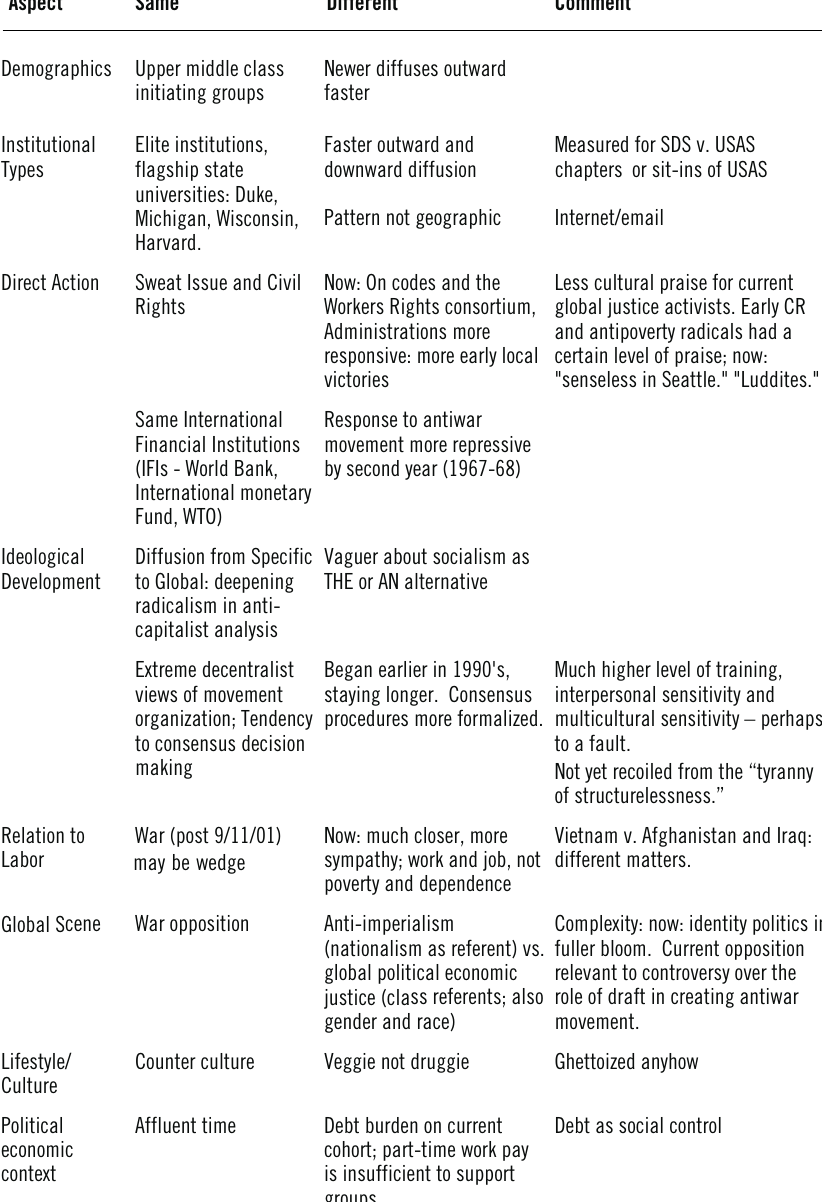
Table 2: Comparing the Old New Left and New New Left